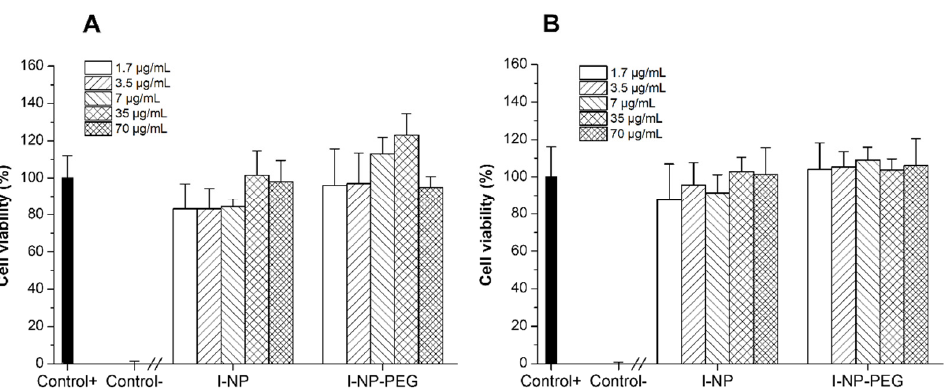
Figure 5. Effect of insulin-loaded nanoparticles (I-NP and I-NP-PEG) on the viability of ( A ) Caco-2 cells, and ( B ) HT29-MTX cell lines. Data presented as mean ± S.D. ( n = 3).